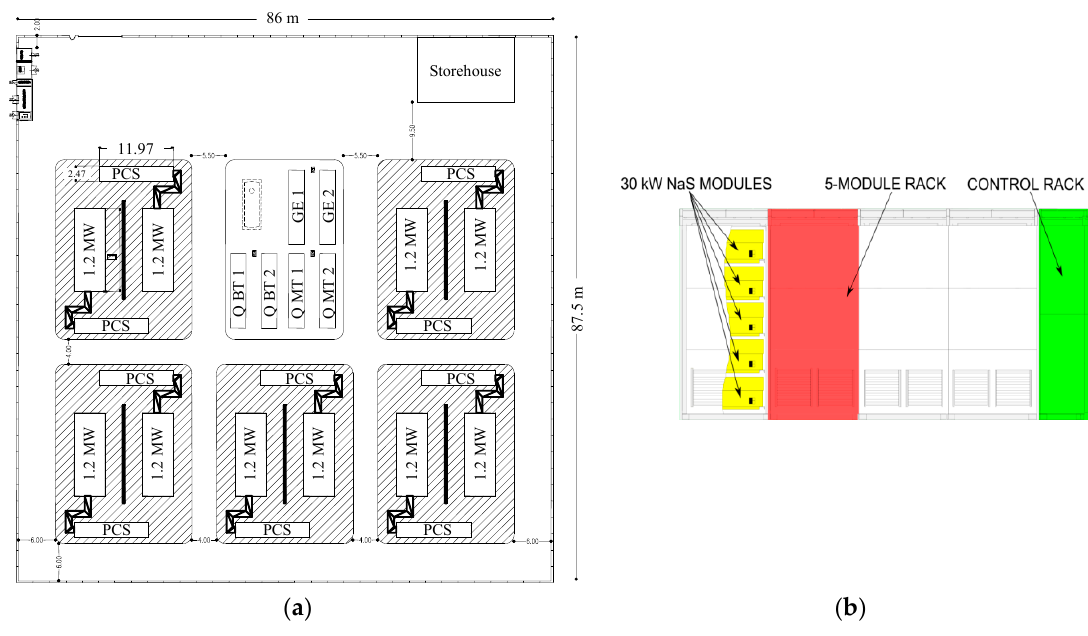
Figure 1. ( a ) 12 MW installation constituted of 10 units of 1.2 MW; ( b ) Frontal view of the 1.2 MW unit (the other four racks are back-to-back with the visible ones).